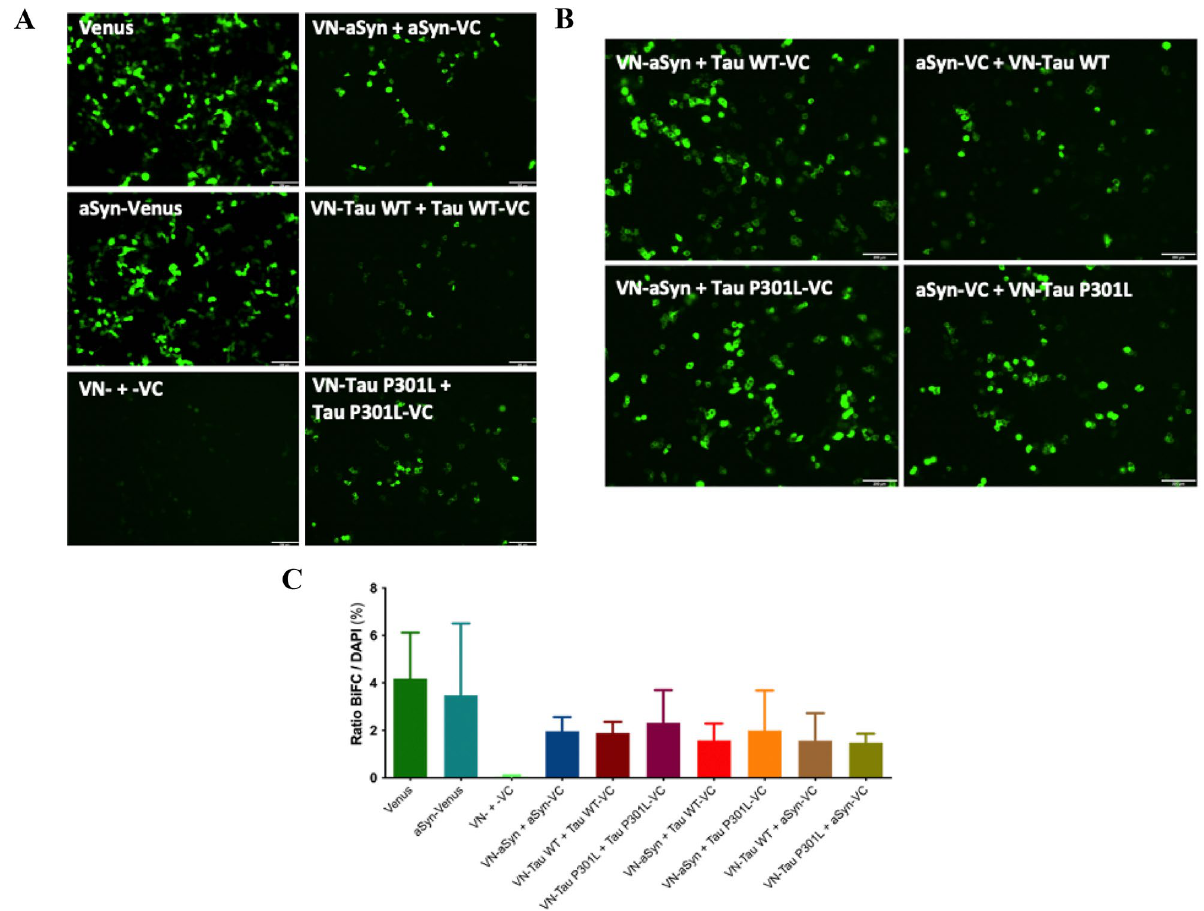
Figure 2. aSyn-Tau interaction in SH-SY5Y human neuroblastoma cells. ( A ) Fluorescence emitted by Venus complementation 24 h post-transfection in SH-SY5Y cells shows self-interaction of aSyn, Tau WT and Tau P301L. SH-SY5Y cells were transiently (co-)transfected with different combinations of the BiFC constructs, and the fluorescence emitted by Venus expression or complementation was recorded 24 h after transfection. Scale bar: 200 µm. ( B ) Fluorescence emitted by Venus complementation 24 h post-transfection in SH-SY5Y cells shows interaction of aSyn with Tau (WT and P301L). SH-SY5Y cells were transiently co-transfected with different combinations of the aSyn and Tau constructs, and the fluorescence emitted by Venus complementation was recorded 24 h after transfection. Scale bar: 200 µm. ( C ) BiFC interaction in (co-)transfected SH-SY5Y cells after 24 h. The percentage of fluorescent (BiFC positive) SH-SY5Y cells in relation to the total number of cells present in the FOV was quantified. Data are expressed as mean ± SD. n =